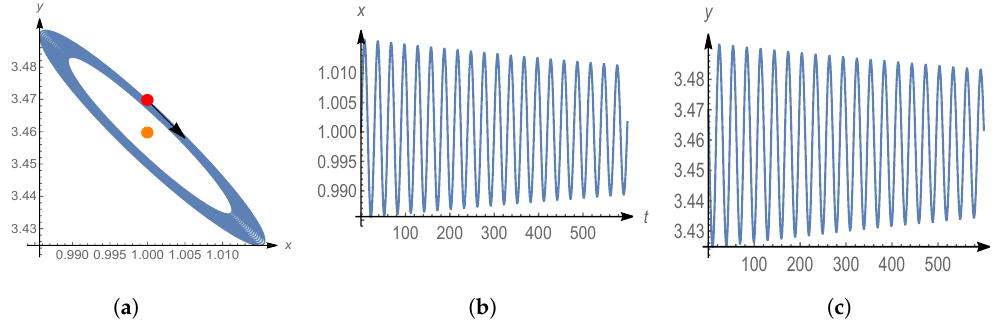
Figure 14. Model 2 with a stable outer and an unstable inner limit cycle. The trajectory is going inward, approaching the point A as t → ∞ and the small limit cycle as t → − ∞ ( d =